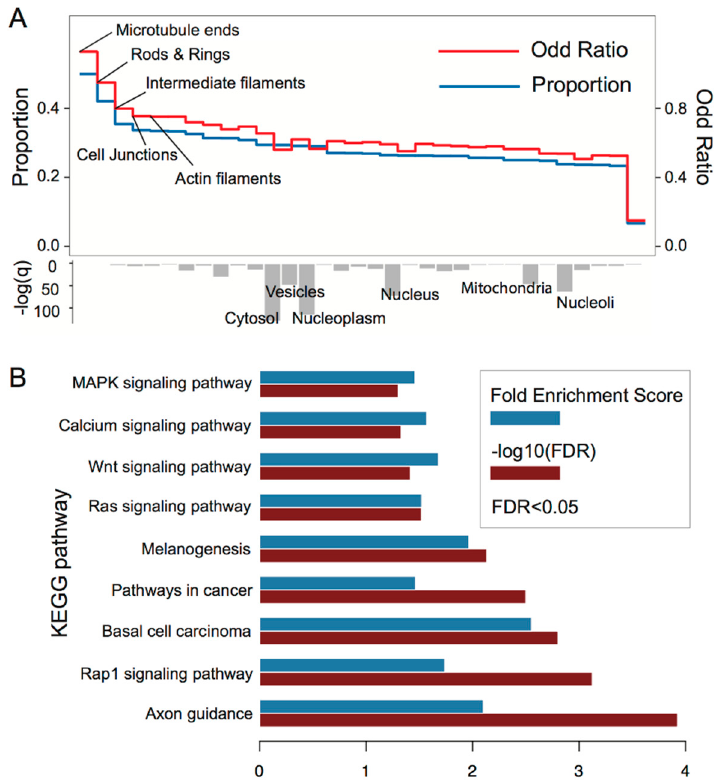
Figure 3. ( A ) Subcellular localization. Blue line denotes the hit proportion of tarGenes across subcellular gene sets. Red line signifies the odd ratio of tarGenes across subcellular gene sets. The bottom bar plot represents the log-transformed q-value (Benjamini–Hochberg adjustment) for enrichment analysis of each subcellular gene set. ( B ) KEGG pathway enrichment analysis, the false discovery rate <0.05.